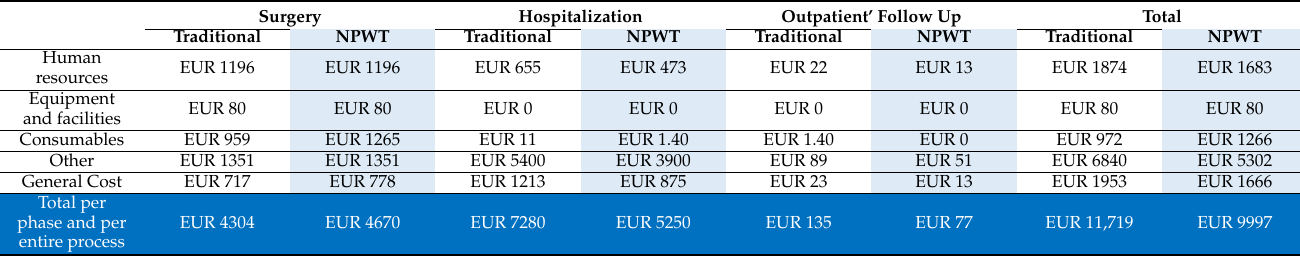
Table 2. Economic valuation of the two patients’